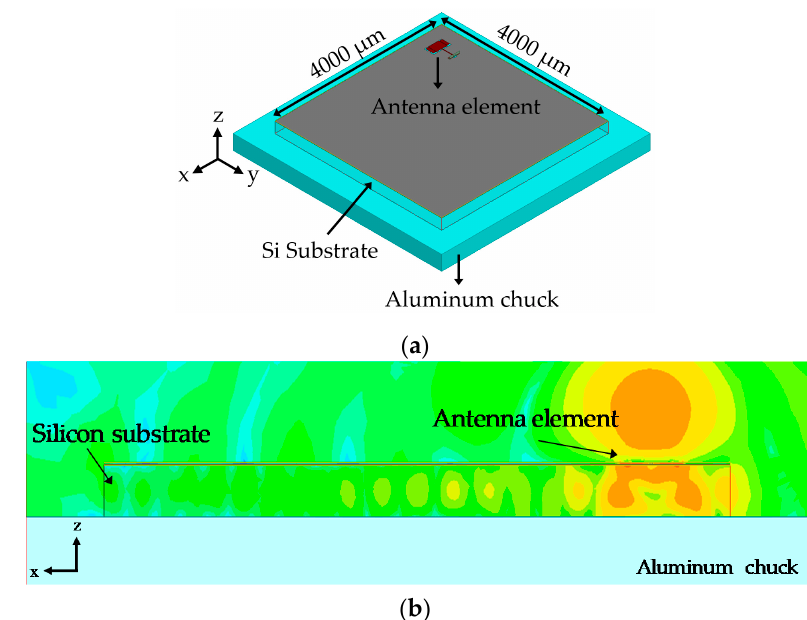
Figure 12. Simulation of antenna element in real substrate size. ( a ) Antenna in 4.0 mm × 4.0 mm silicon substrate. ( b ) Electric field distribution at 300 GHz.